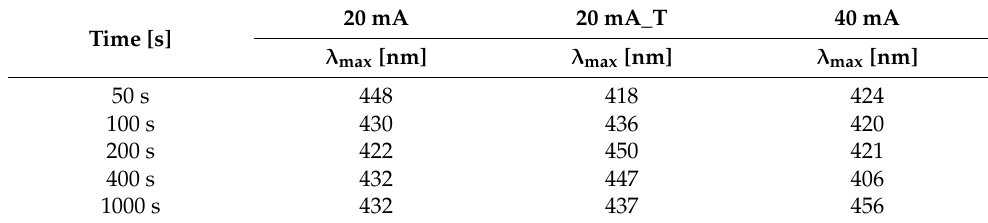
Table 2. Positions of absorption maxima of individual samples.